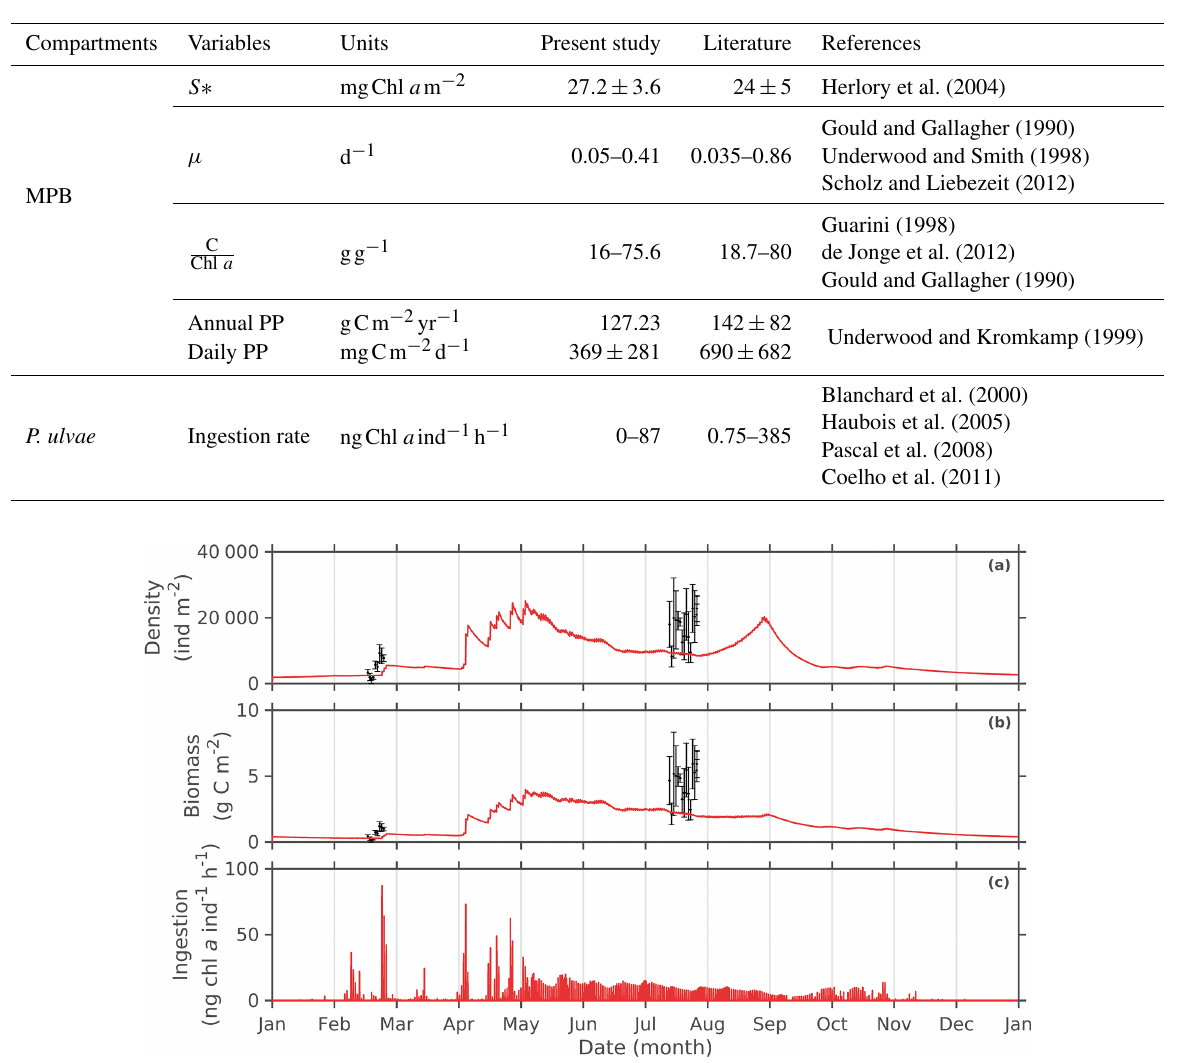
Table 3. Range of values of simulated and observed biological variables.